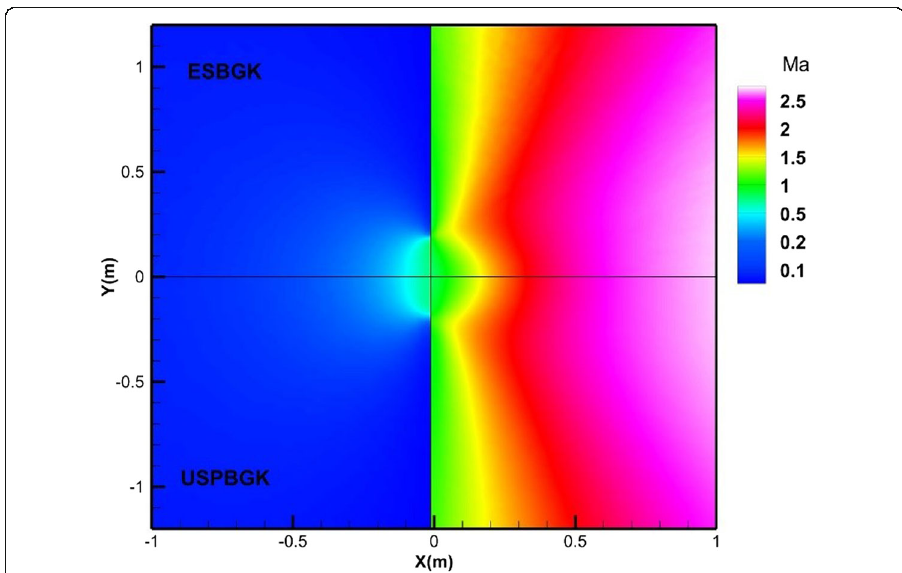
Fig. 6 Comparison of Mach number in gas flow through a slit predicted by ESBGK and USP-BGK